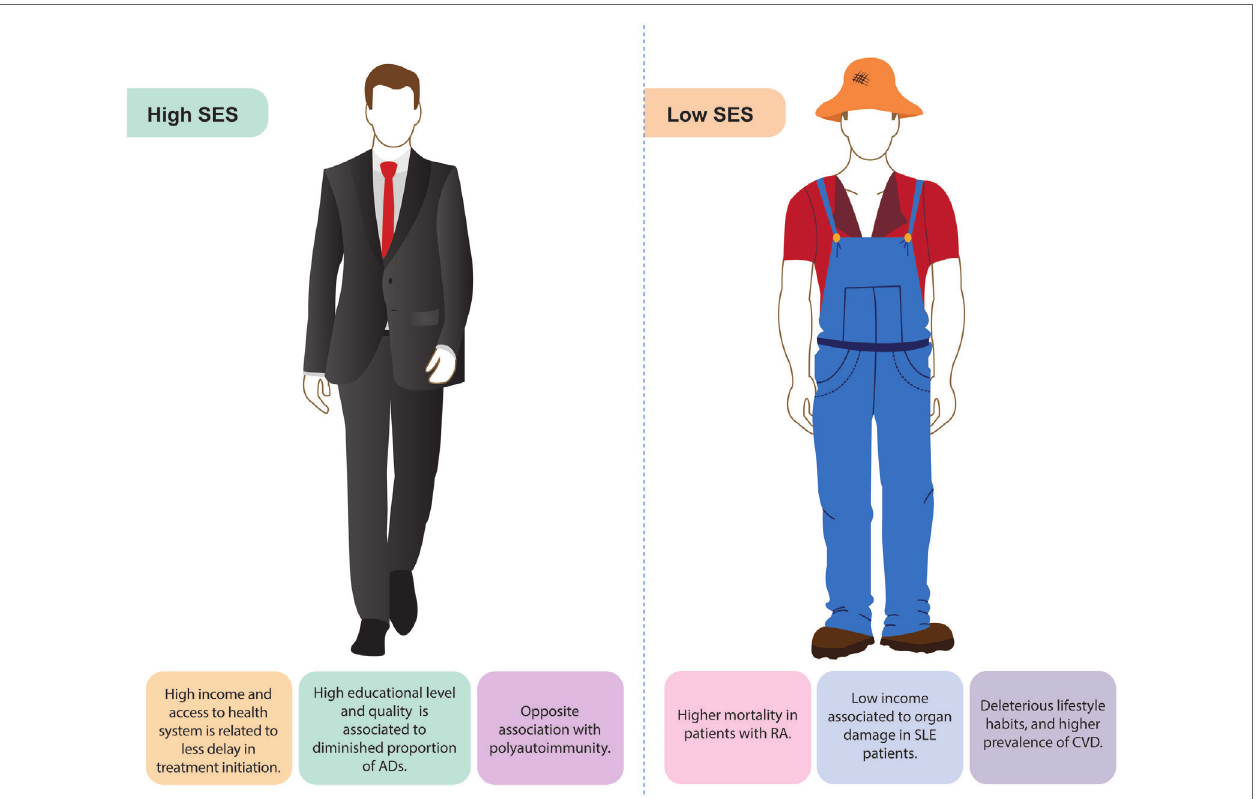
FiGURe 8 | Socioeconomic status (SeS) and autoimmune diseases (ADs). Some of the main findings associated with autoimmune diseases related to high or low socioeconomic position are